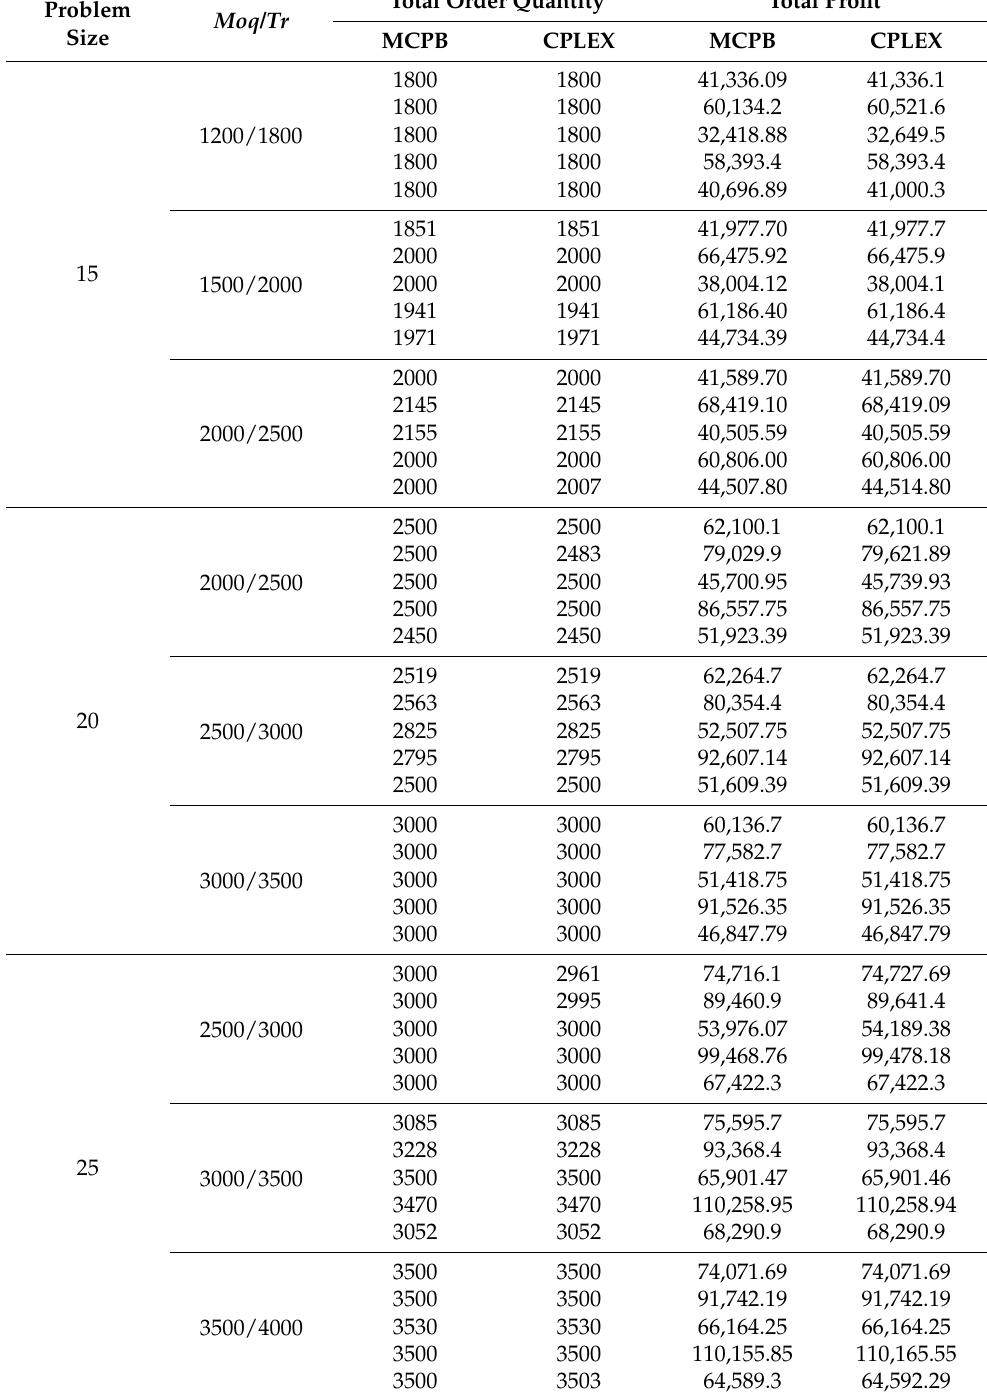
Table A1. The results of all scenarios in Experiment